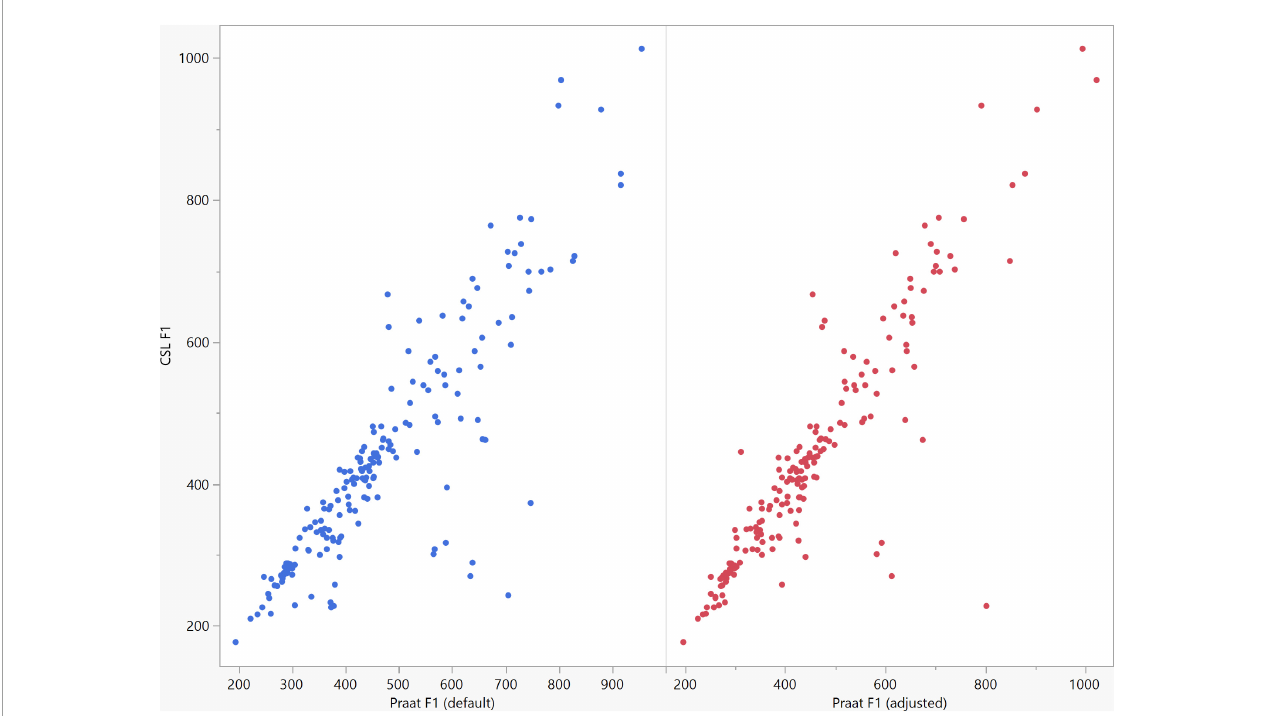
FIGURE7 Correlation between the F1 data of the five vowels calculated using Computerized Speech Lab (CSL) and Praat. The CSL F1 data showed strong positive correlations with those calculated by Praat for both the default (rs = 0.867, n = 185, p < 0.0001*) and adjusted (rs = 0.894, n = 185, p < 0.0001*).